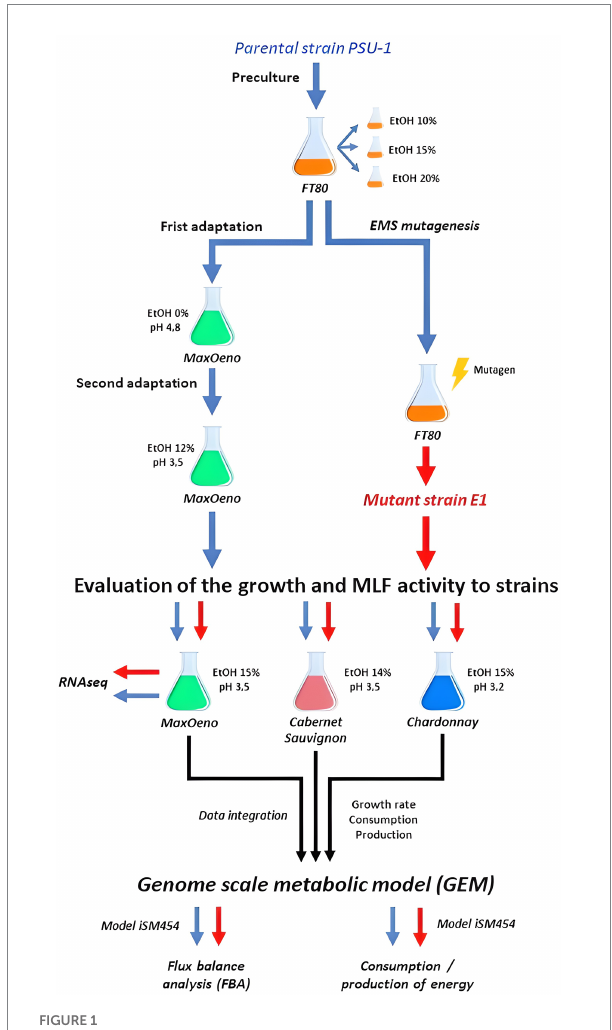
FIGURE 1 Full experimental process